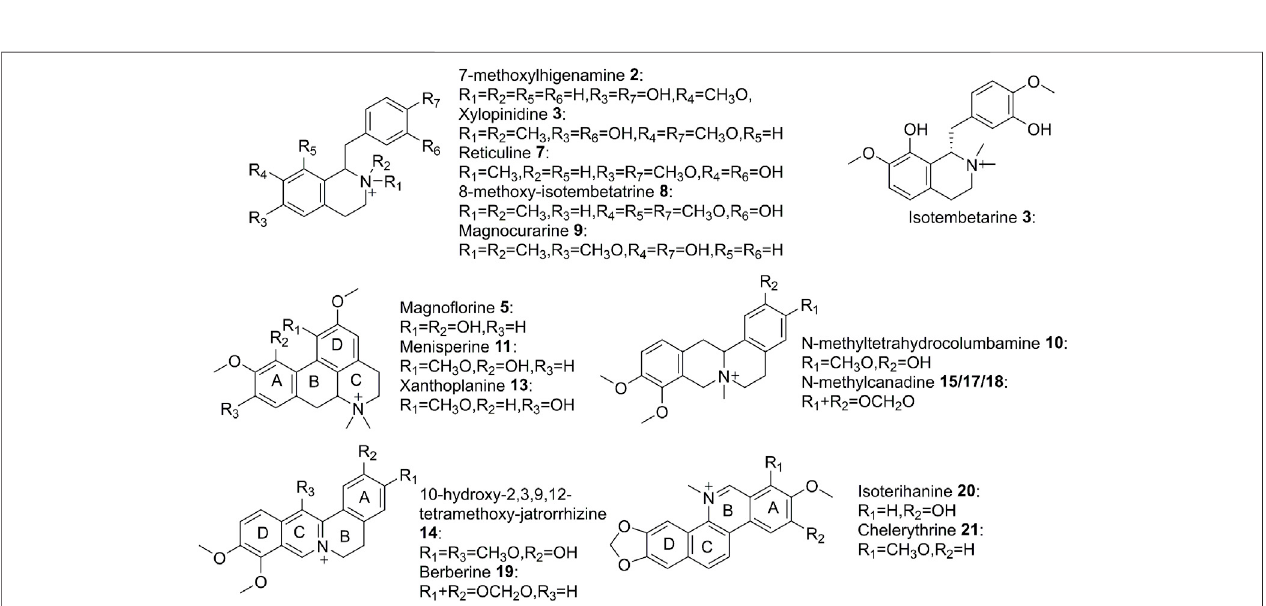
FIGURE 2 | UF-LC chromatograms of the potential ligands from total alkaloids of Z. simulans for JAK2 and Tyk2. These two JAKs were boiled to get inactive kinases and conducted ultra fi ltration in parallel. The colors, blue and cyan, were employed to present active and inactive JAK2 treatment, while wine and violet for active and inactive JAK3, respectively.